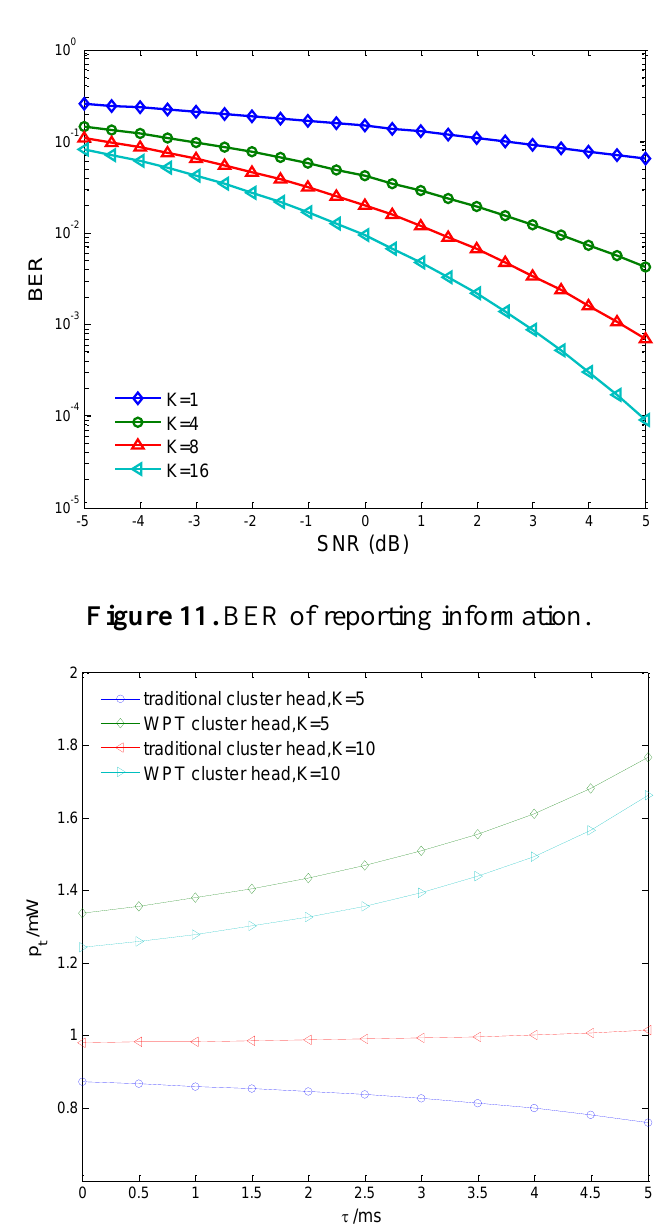
Figure 12. Transmission power of cluster